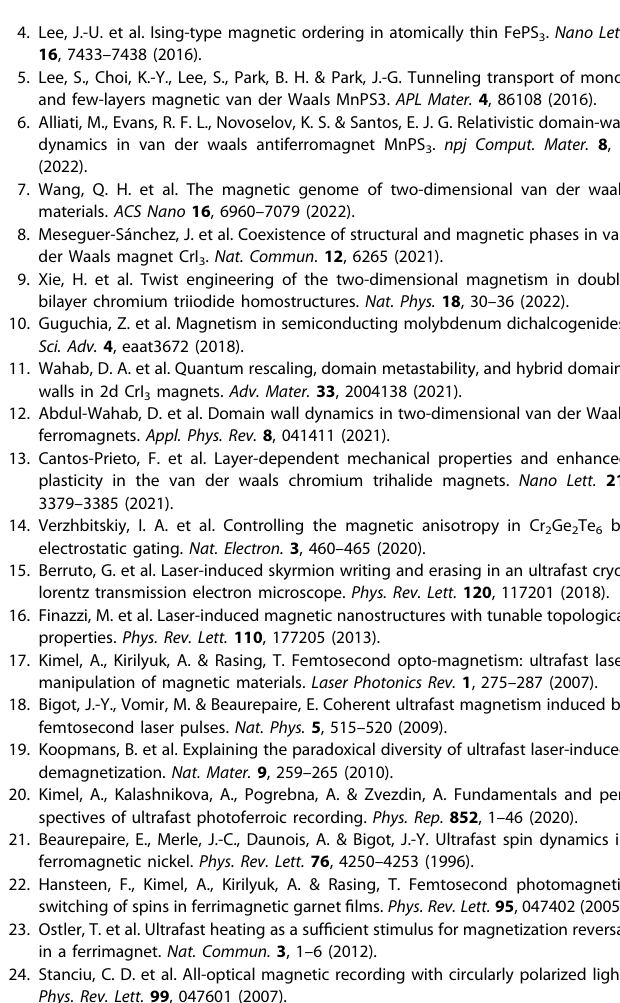
Fig. 5 Topological number as a descriptor. a , b Variation of the topological number N within 0 − 400 ps and 400 − 1000 ps intervals, respectively. Laser pulse fl uence at 0.01 mJ cm − 2 . c – f , Snapshots of the spin dynamics of monolayer CrCl 3 at different times highlighted in ( b ). The different jumps ( c – f ) represent selected areas where the annihilation of a vortex/antivortex pair is present which is associated with an unit variation of N